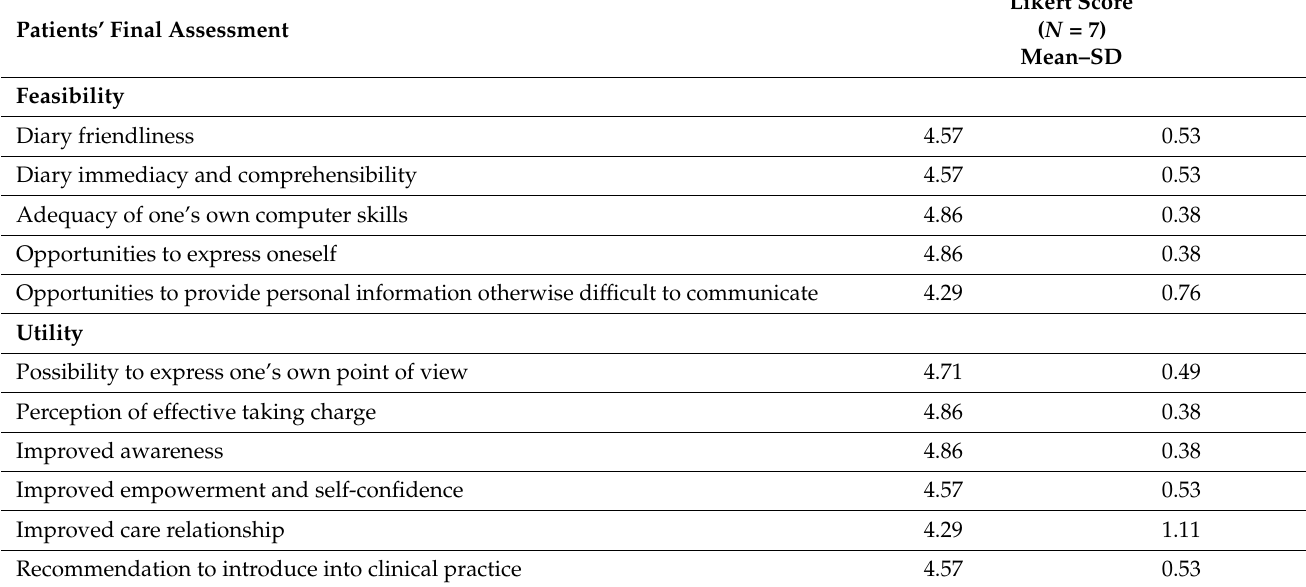
Table 2. Evaluation of the digital narrative diary by